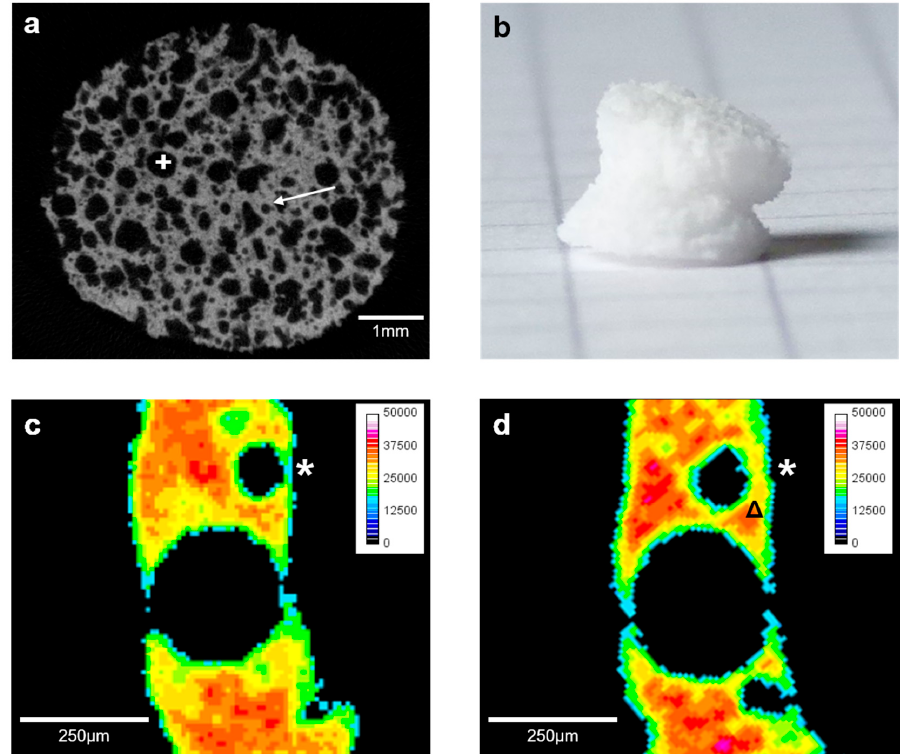
Figure 3. Characterization of Group B scaffolds: representative 2D-µCT-image ( a ); a photograph of the scaffold (edge length of the squares in the background: 5 mm) ( b ); 2D density color-coded µCT-slices (calibration bar in HU) of a defined scaffold region at T0 ( c ) and after 56 days in immersion ( d ). The 2D-µCT-slide shows the typical structure of the bioactive glass (BG)-based scaffold ( a ), with medium sized pores (+) surrounded by smaller pores ( → ). During immersion, the boundaries of the scaffold became thicker, most likely because of hydroxycarbonate apatite (HCA) formation as a result of BG dissolution (*). The outer shell of the scaffold remained with a lower density, however, the parts underneath ( Δ ) showed higher density. Table 1. Data for the µCT-characteristics of the analyzed scaffolds (groups A and B) for T0, mean values with standard deviation of the mean in brackets. TV: total volume, SV: scaffold volume, SA: surface area, P: porosity, PN: pore number, rPN: relevant pore number, PS: mean pore size). Δ % represents the percentage difference comparing A- and B-groups. p shows the p -values comparing A- and B-groups; significant differences are distinguished by (*).